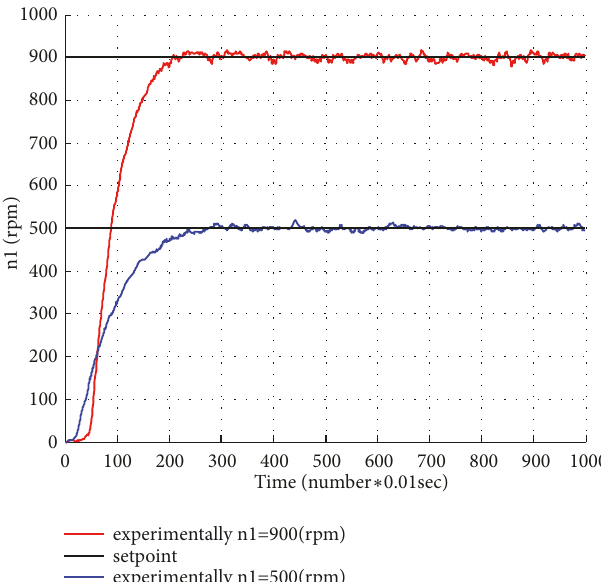
Figure 19: Velocity response of the working shaft at oil temperature of 80 ∘